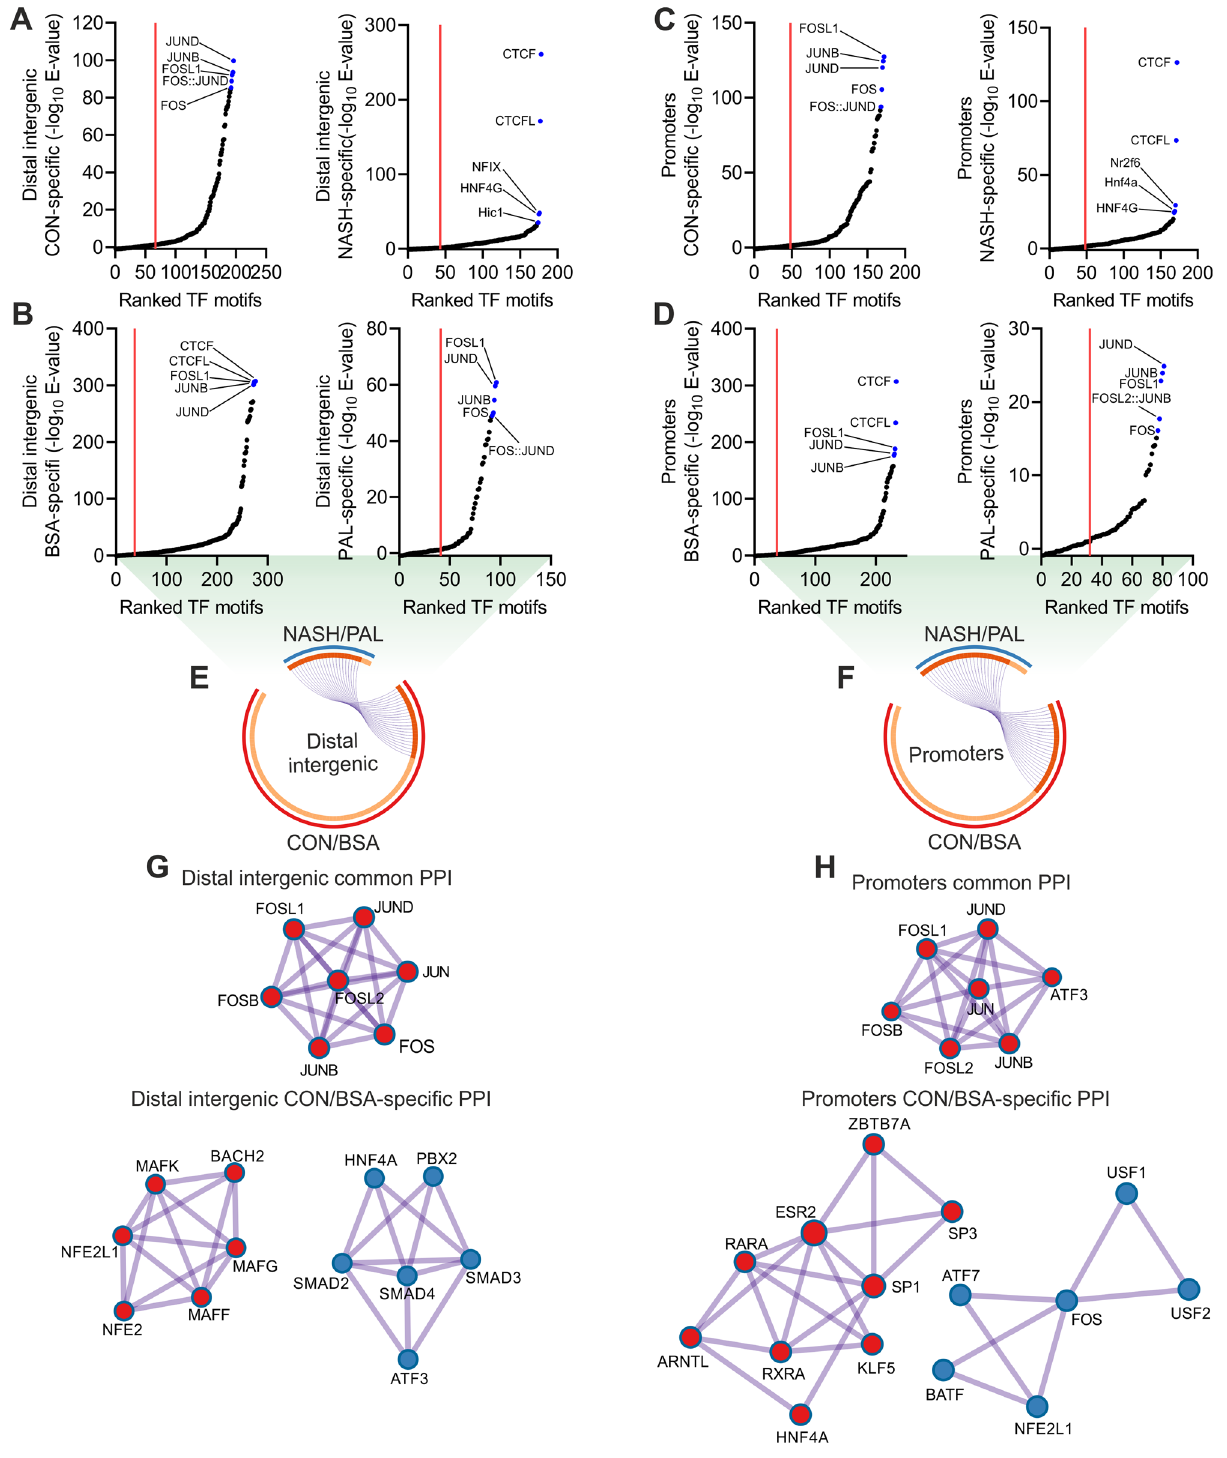
Figure 4. Conserved transcription factor networks at regulatory elements in NASH and lipotoxicity. ( A – D ) Transcription factor motif enrichment analysis in chromatin regions showing a loss (CON/BSA-specific) or gain (NASH/PAL-specific) in accessibility at ( A , B ) distal intergenic regions and ( C , D ) promoters in the context of NASH or PAL treatment (red line denotes significance cut-off of E-value < 0.05). ( E , F ). Circular plots showing conserved transcription factors (purple lines) shared between CON/BSA- and NASH/PAL-specific chromatin regions at ( E ) distal intergenic regions and ( F ) promoters. ( G , H ) Protein–protein interaction (PPI) network analysis of common and CON/BSA-specific transcription factors at ( G ) distal intergenic regions and ( H )